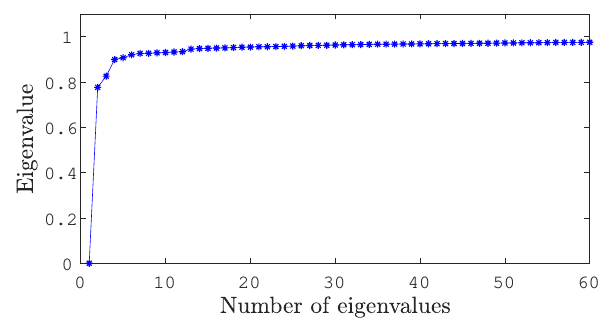
Figure 6. The 60 smallest eigenvalues from the Spectral Clustering analysis based on the calculated occlusion sensitivity